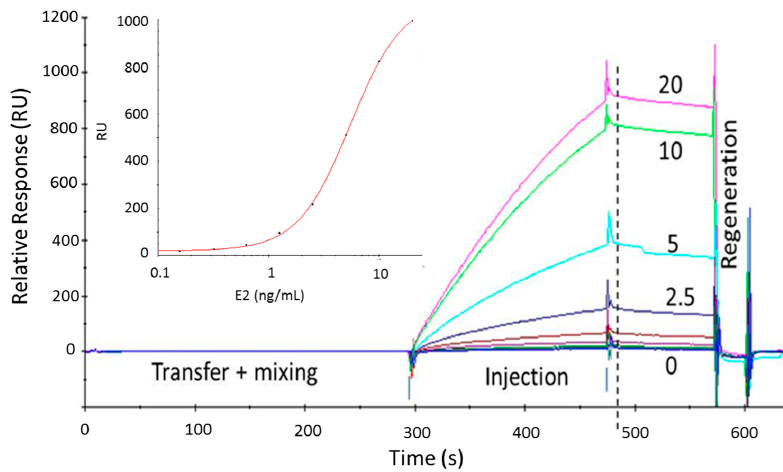
Figure 3. Referenced SPR sensorgrams obtained in the Biacore 3000 with E2 concentrations ranging from 0 to 20 ng/mL. The standard solutions in 20% methanol and the wt-ER α LBD in HBS-EP (10 mM Hepes, 150 mM NaCl, 3 mM EDTA, 0.005% Tween-20) buffer were transferred and mixed in the Biacore (1:1; v / v ). Of this mixture, 90 µL was injected over the peptide-coated sensor surface at a flow rate of 30 µL/min using HBS-EP as running buffer. After the injections, the responses were measured (dotted line) and used for the construction of the calibration curve (insert). The binding of the ER was regenerated by the injection of 10 mM NaOH for 0.5 min. The total time of each cycle was 11 min of which 5 min were used for the transfer and mixing.